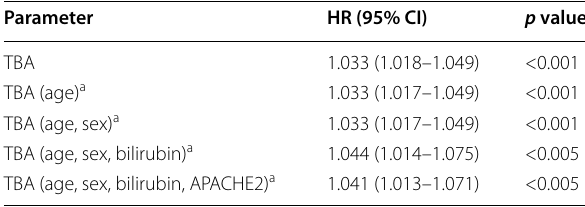
CI confidence interval a Corrected for covariates in brackets, HR, hazard ratio per increase of